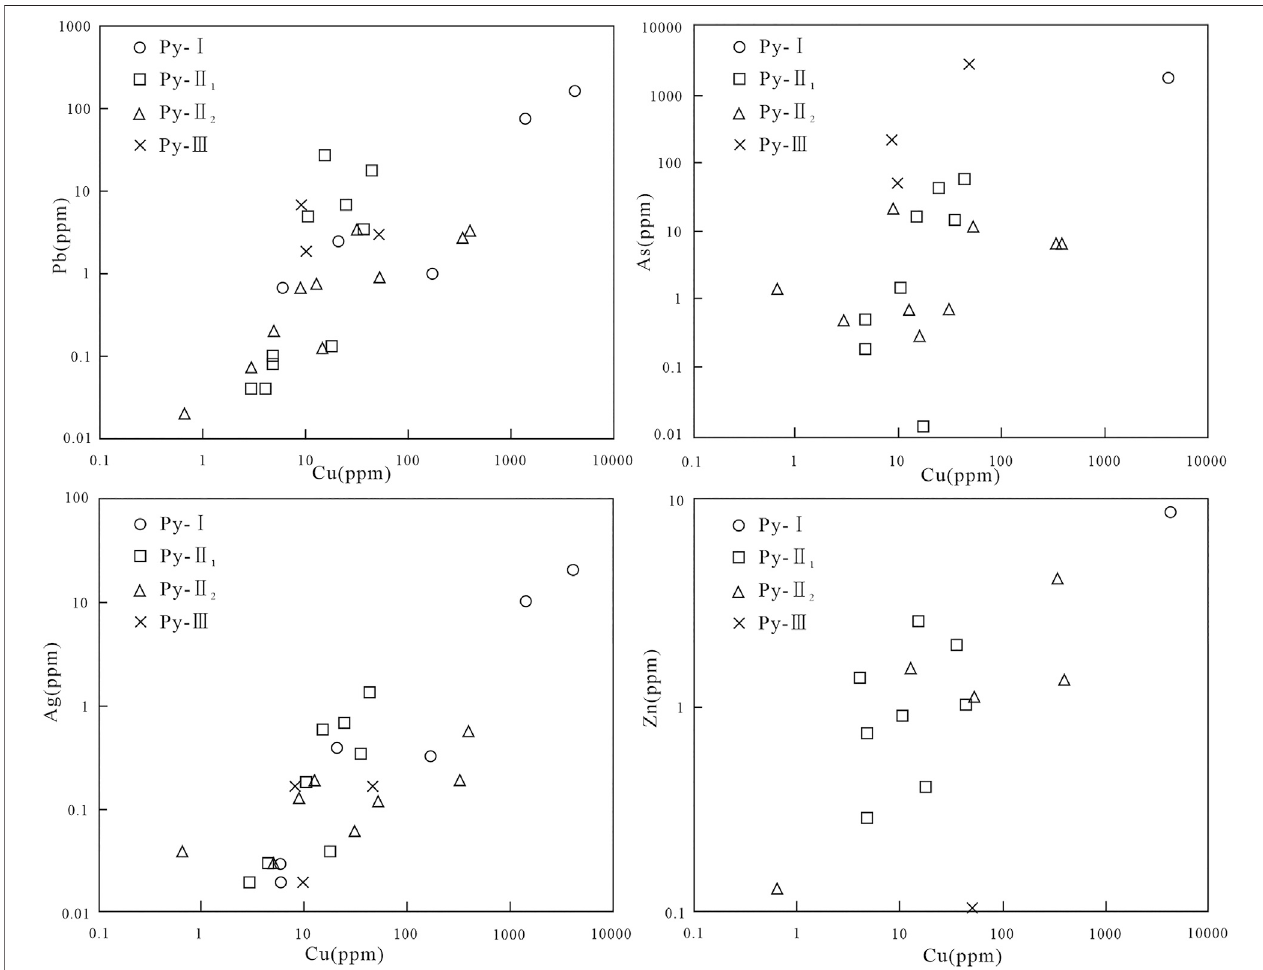
FIGURE 10 | Correlation diagrams for the trace elements of pyrite from the Tuwu porphyry Cu deposit in eastern Tianshan, Xinjiang, NW China.